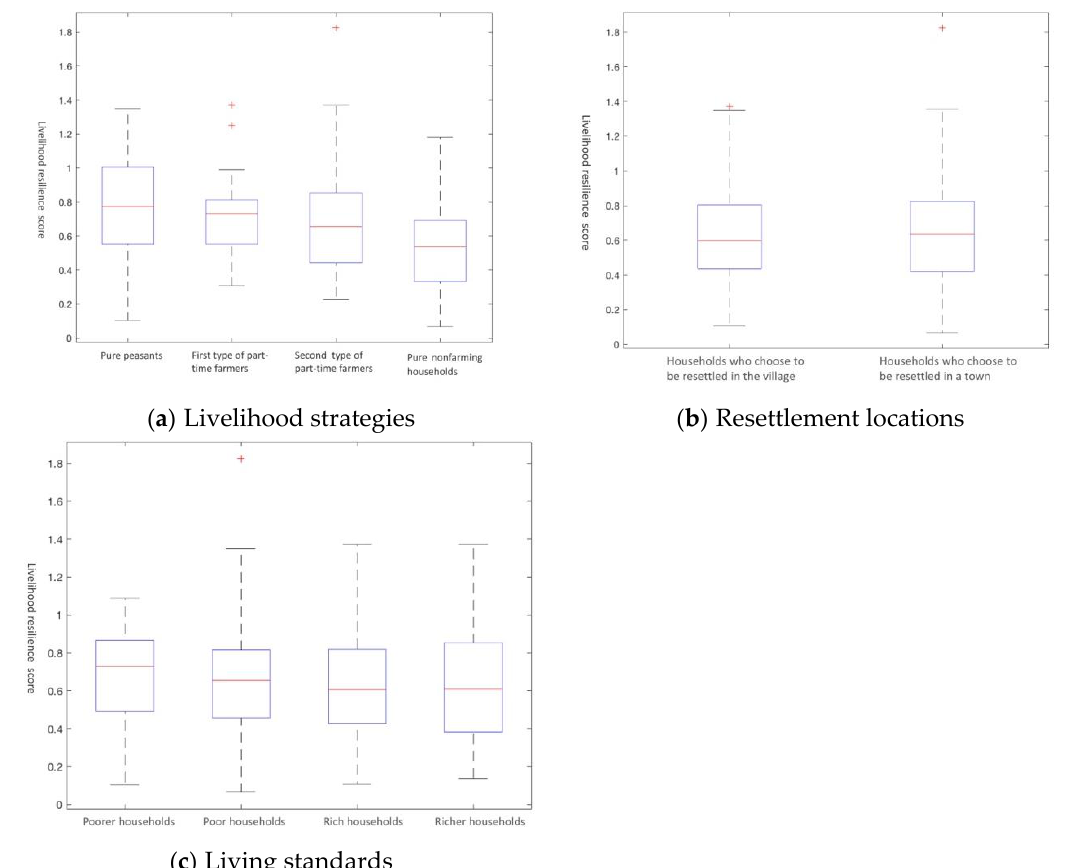
Figure 5. Box plots of the 307 RAFs’ livelihood resilience scores by livelihood strategy, resettlement location, and living standards. ( a ) A box plot of livelihood resilience scores for 307 RAFs with di ff erent livelihood strategies; ( b ) A box plot of livelihood resilience scores for 307 RAFs with di ff erent resettlement locations; ( c ) A box plot of livelihood resilience scores for 307 RAFs with di ff erent living standards. Source: designed by the authors.